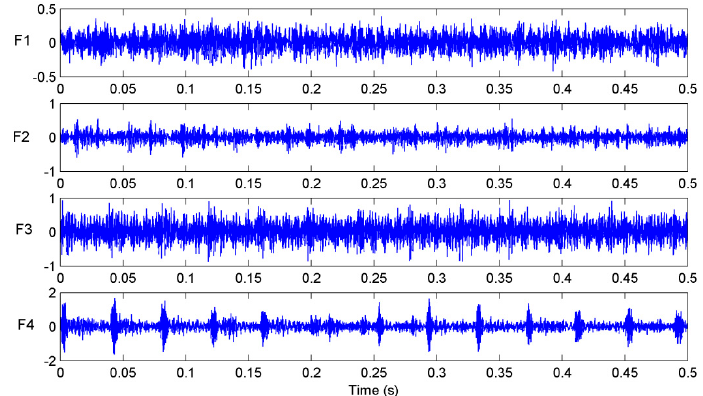
Figure 4. The vibration acceleration signals of each shearer cutting status.